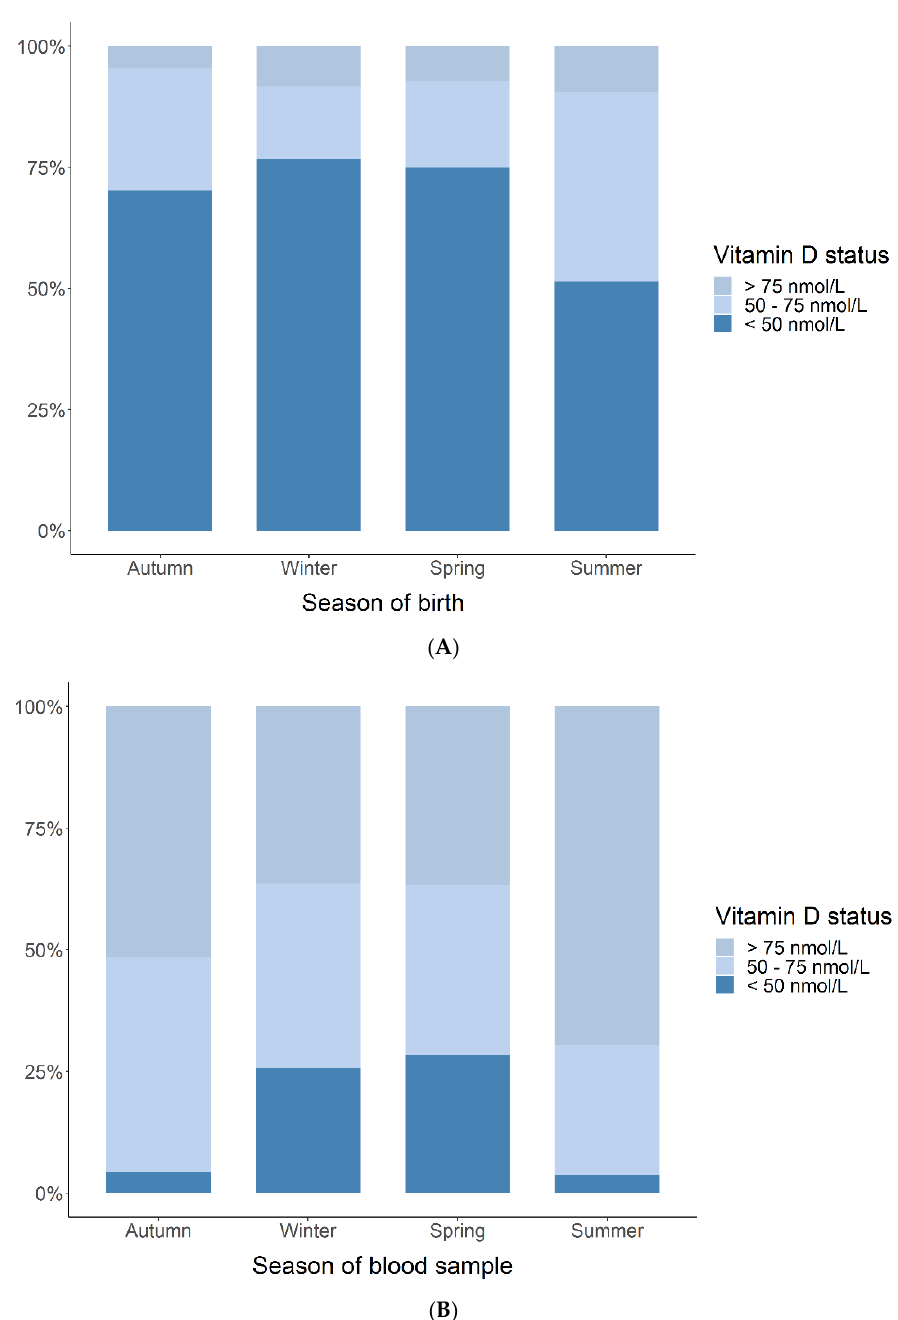
Figure 3. Child 25(OH)D status (deficient (<50 nmol/L), insufficient (50–75 nmol/L), sufficient (>75 nmol/L)) measured in cord blood ( A ) and at 4 years ( B ) stratified for season of blood sampling. When using winter as reference, cord blood levels of 25(OH)D were 12.3 nmol/L higher in children born during summer (95% CI [5.5; 19.3], p < 0.001). For age 4 years, the levels measured during summer and autumn were 19.1 nmol/L (95% CI [11.1; 27.1], p < 0.001) and 12.4 nmol/L (95%